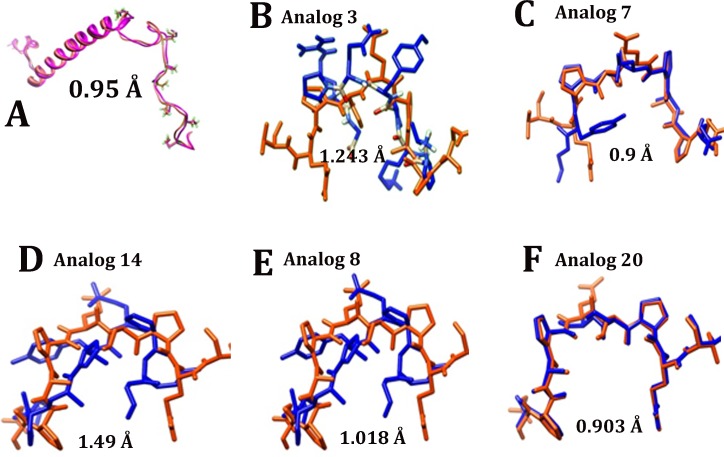
Comparative modeling of GILZ analogs: Superimposition of human delta sleep inducing peptide (DSIP; PDB: 1DIP) with the predicted model of human GILZ (A), superimposition of indicated analog (blue) with the critical residues in the proline glutamic acid rich region of human GILZ model (red) (B-F). Structural similarity in terms of root mean square deviation (RMSD) for each superimposition is indicated.